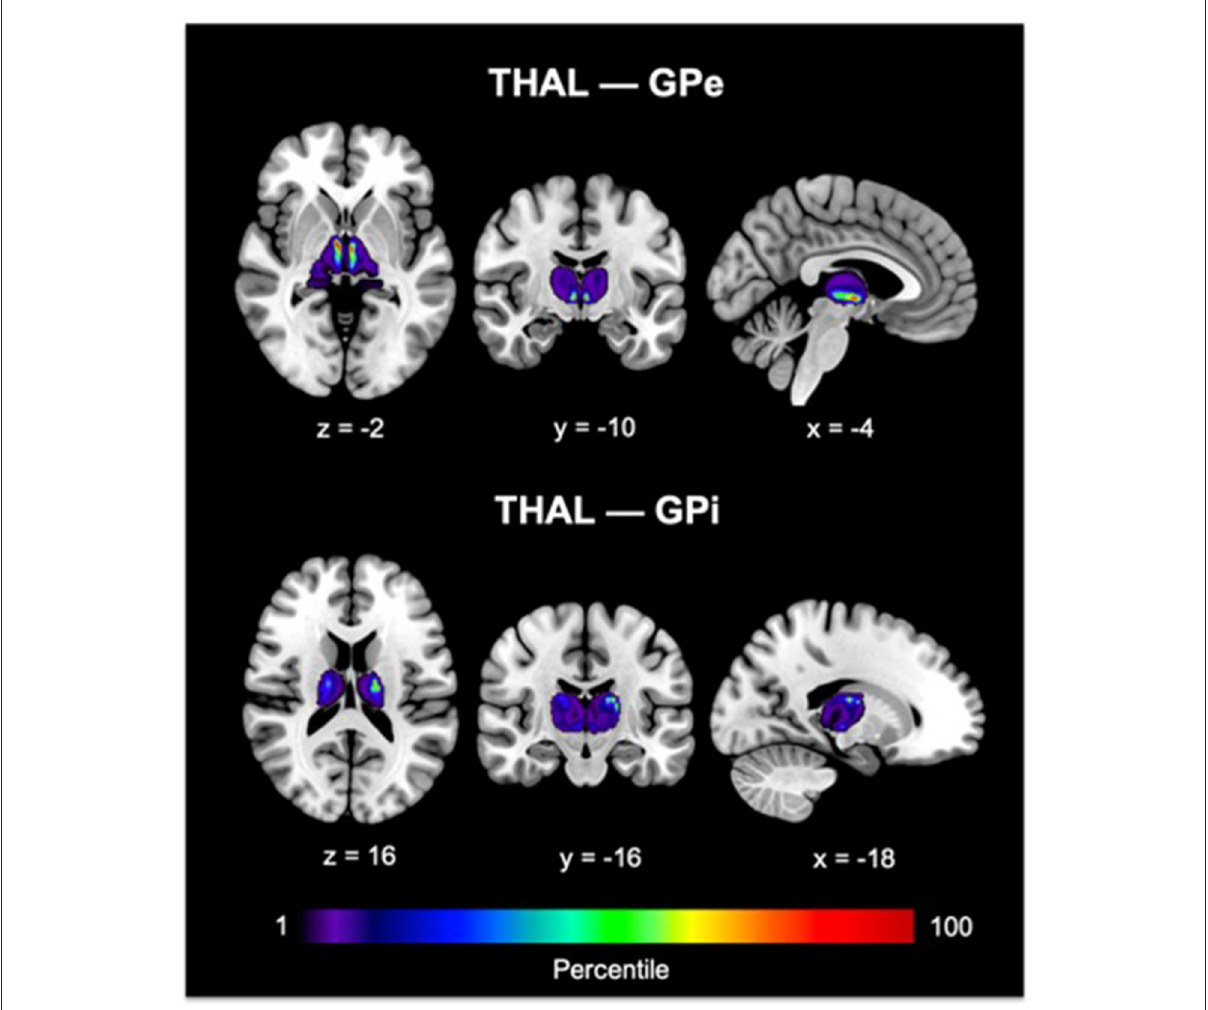
FIGURE5 GPe and GPi connectivity within thalamus are shown. Color bars reflect the percentile of connections. For THAL—GPe connections, peak voxel was found in the central medial intralaminar nucleus. For THAL—GPi connections, peak voxel was identified in the ventral lateral thalamus. The Morel thalamic atlas was used as an anatomical guide. GPe, external globus pallidus; GPi, internal globus pallidus; THAL,